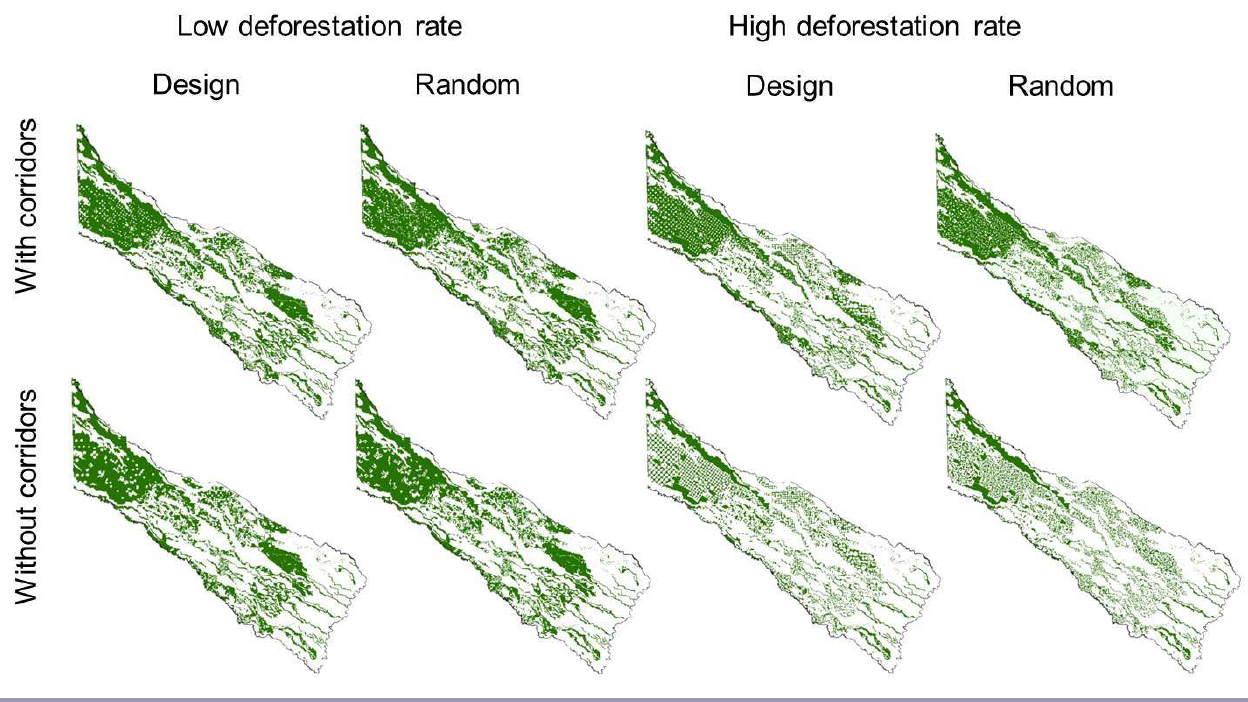
Fig. 3. Forest cover (in green) in Formosa under four scenarios of spatial planning at regional and plot level, and for two deforestation rates. Where replicate runs were carried out, scenarios are exemplified by showing one of these replicate runs.